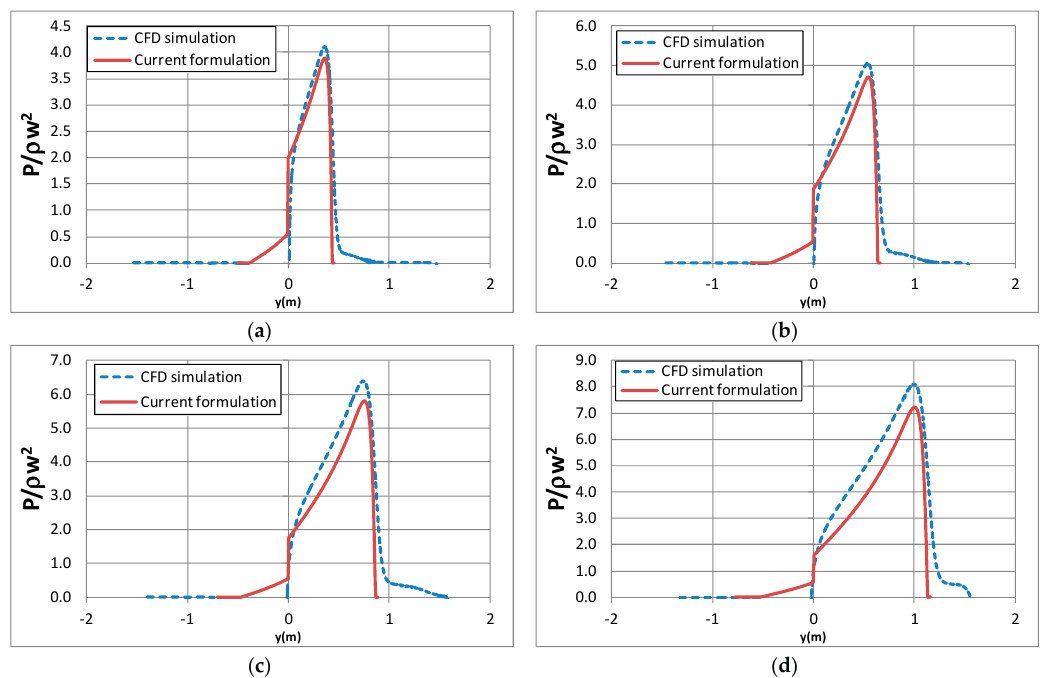
= − 10 ◦ . ( a ) z = 0.3 m. ( b ) z = 0.4 m. ( c ) z = 0.5 m. 0 0 0 0